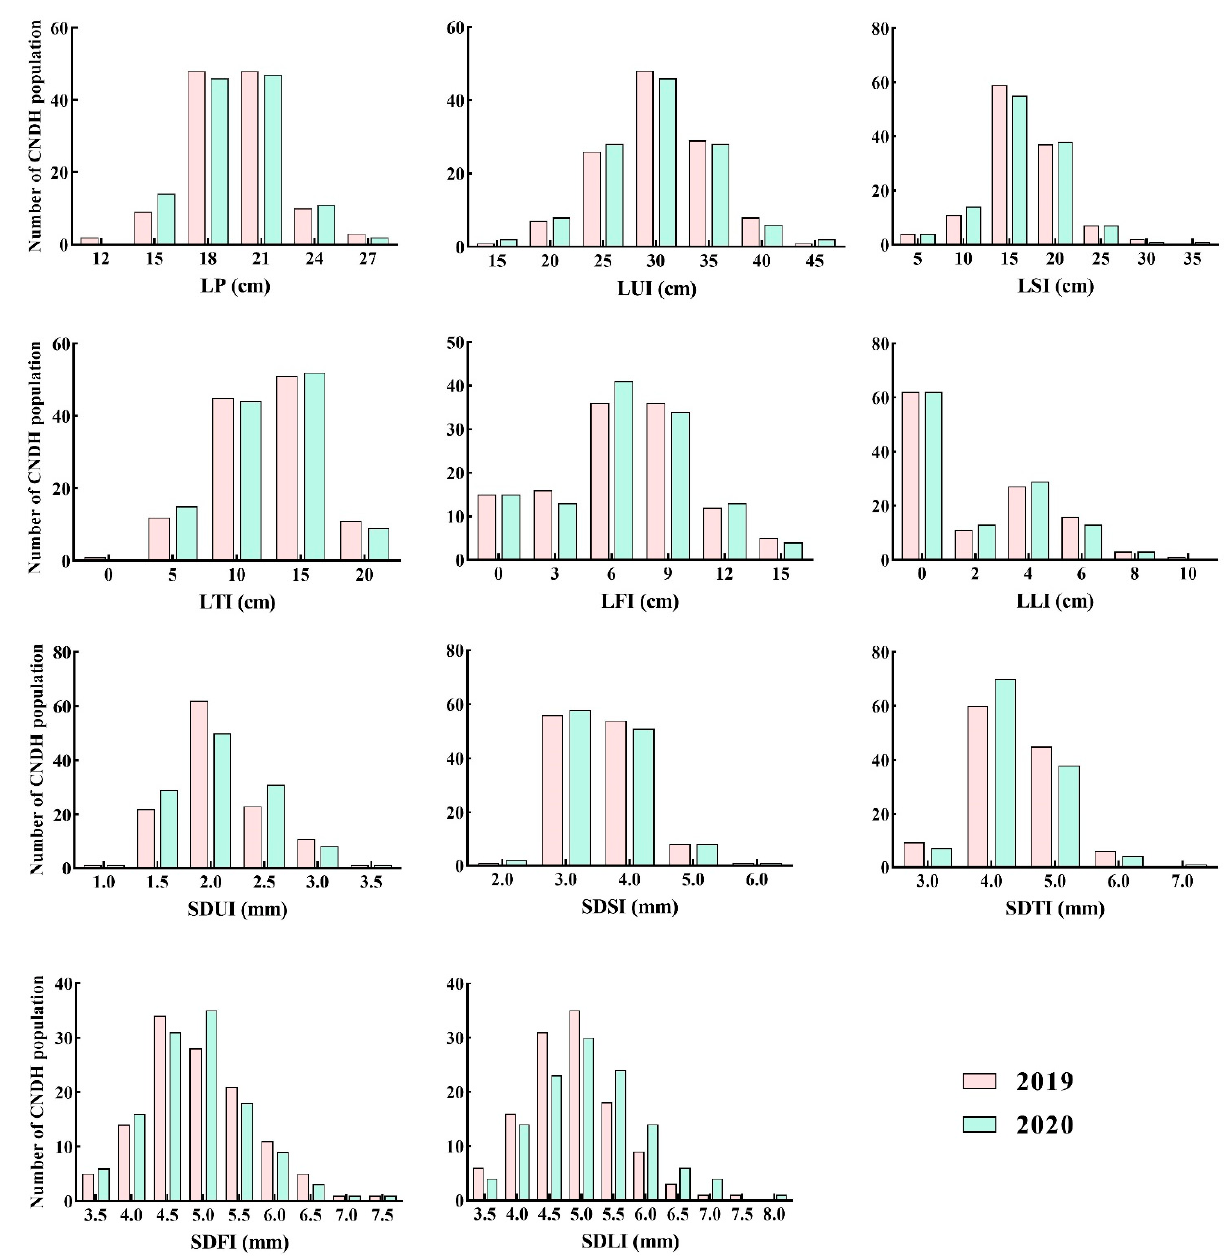
Figure 2. Frequency distribution of the length of each internode and the stem diameter of each internode in the Cheongcheong/Nagdong doubled haploid (CNDH) population. LP, length of the panicle; LUI, length of the uppermost internode; LSI, length of the second internode; LTI, length of the third internode; LFI, length of the fourth internode; LLI, length of the lowest internode; SDUI, stem diameter at the uppermost internode; SDSI, stem diameter at the second internode; SDTI, stem diameter at the third internode; SDFI, stem diameter at the fourth internode; SDLI, stem diameter at the lowest internode.